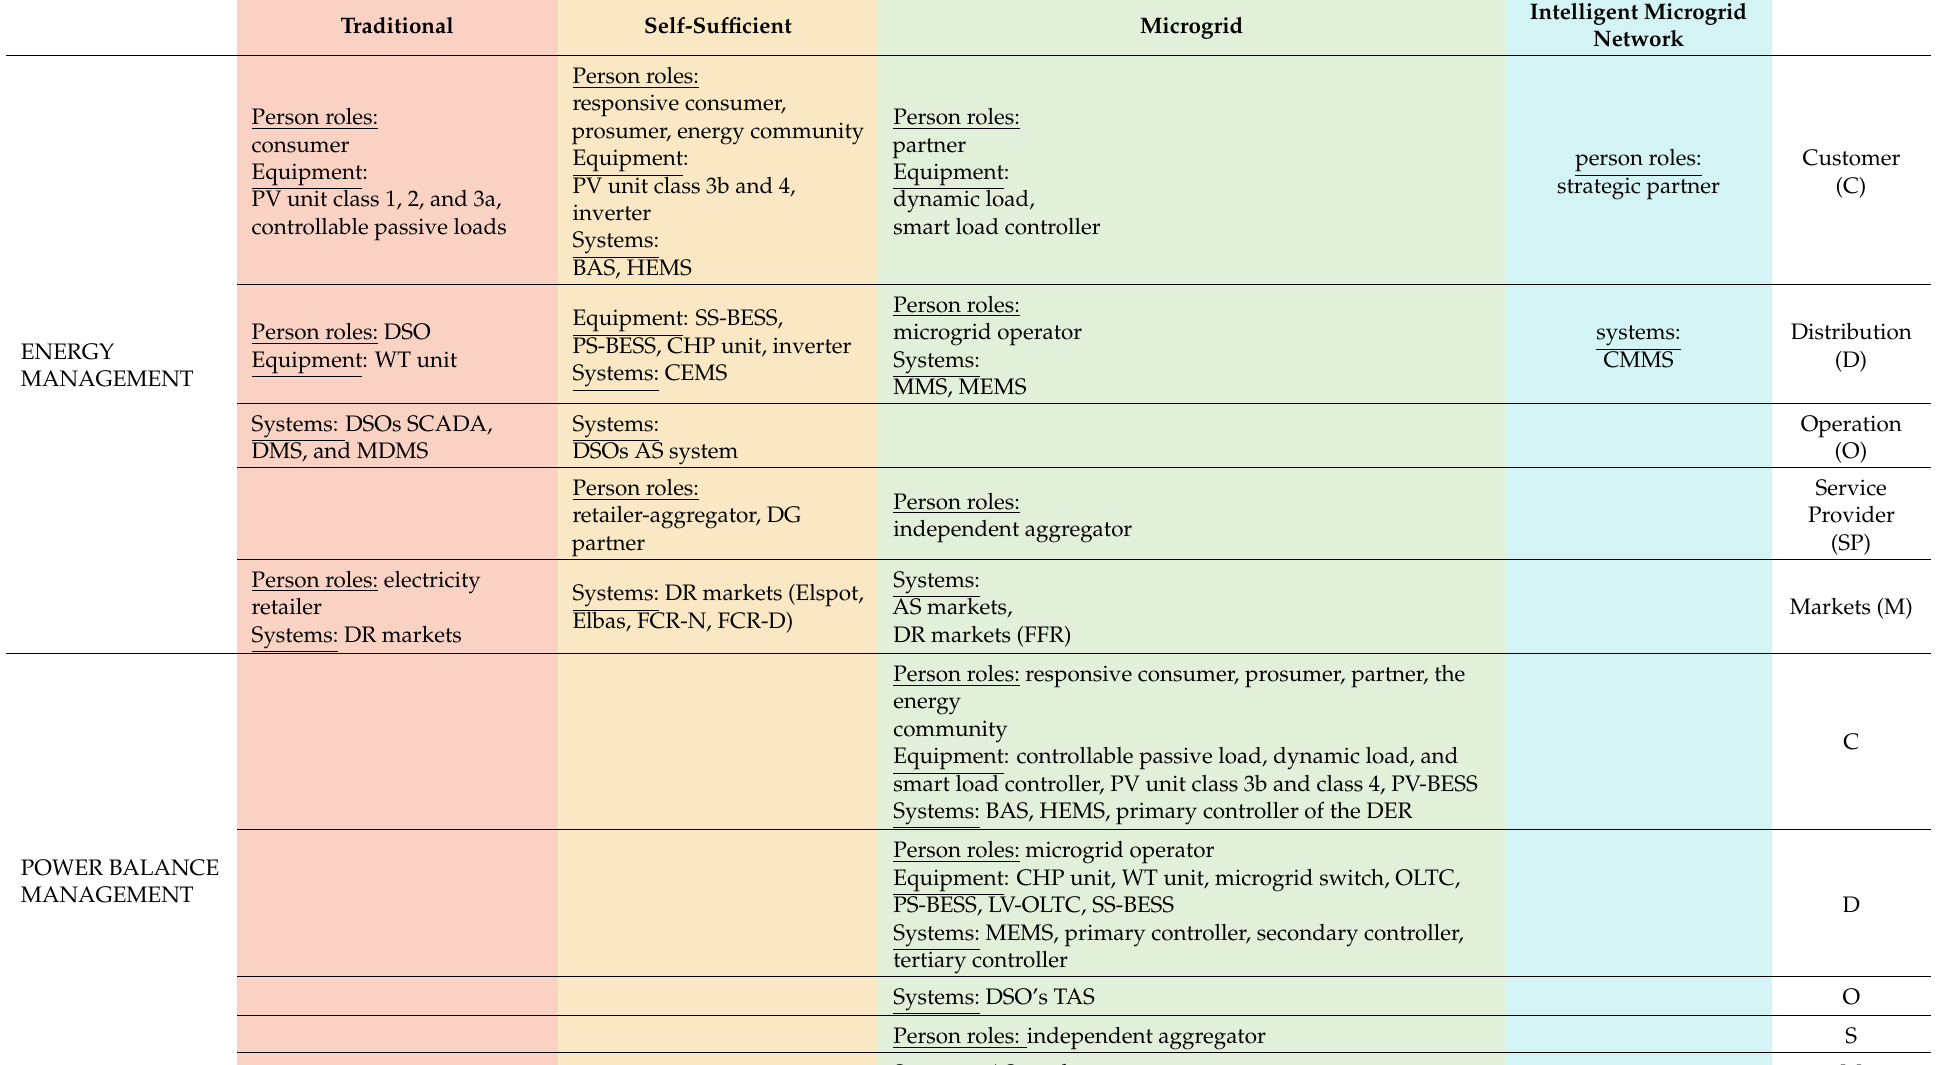
Table 8. Classified actors of the evolving electricity distribution